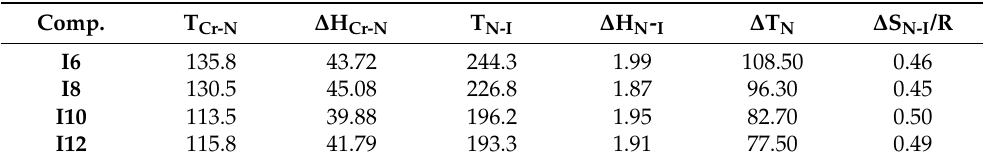
Table 1. Transition temperatures of phases (°C), (enthalpy ΔH , kJ/mole), mesomorphic range ( Δ T ), and normalized entropy, ΔS/R of transition for series I n .